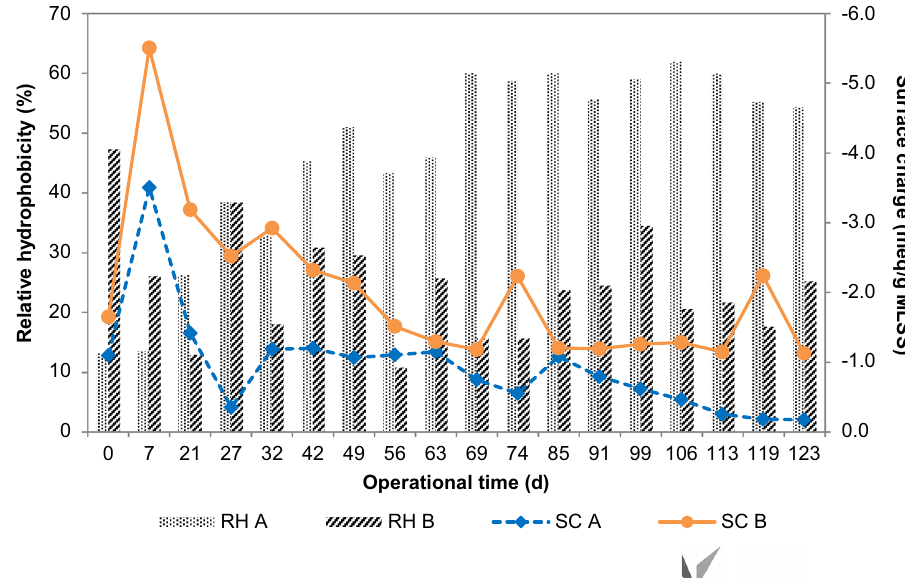
Fig. 4 Relative hydrophobicity (RH) and surface charge (SC) profiles of biomass for SBR A and SBR